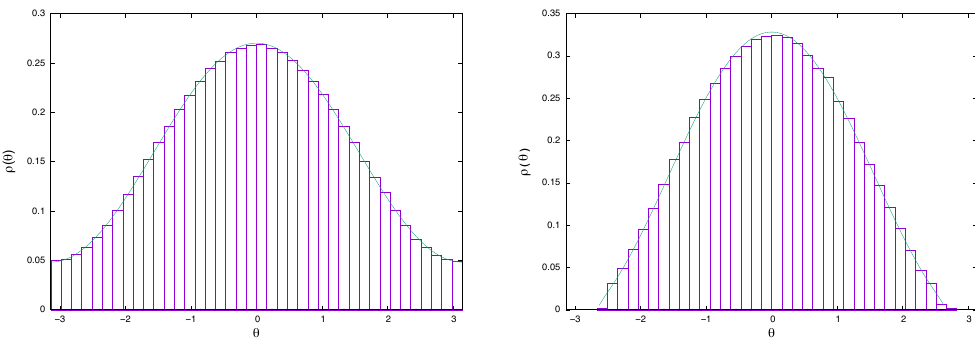
Figure 5 . The distribution of Polyakov line phases. [Left] (cid:22) = 3 : 0, where the partially decon(cid:12)ne- ment phase is stable. We have plotted the distribution at N = 32, the number of lattice points L = 18, and temperature T = 1 : 15, which is in the middle of the partially decon(cid:12)ned phase. The (cid:0) (cid:1) (cid:12)t is (cid:26) ( (cid:18) ) = 1 1 + 2 cos (cid:18) with (cid:20) = 2 : 87. [Right] (cid:22) = 5 : 0, where the partially decon(cid:12)nement 2 (cid:25) (cid:20) phase is unstable and the transition is of (cid:12)rst order. We have plotted the distribution at N = 128, L = 16, T = 1 : 54, which is very close to T 2 . The (cid:12)t is (cid:26) ( (cid:18) ) = 2